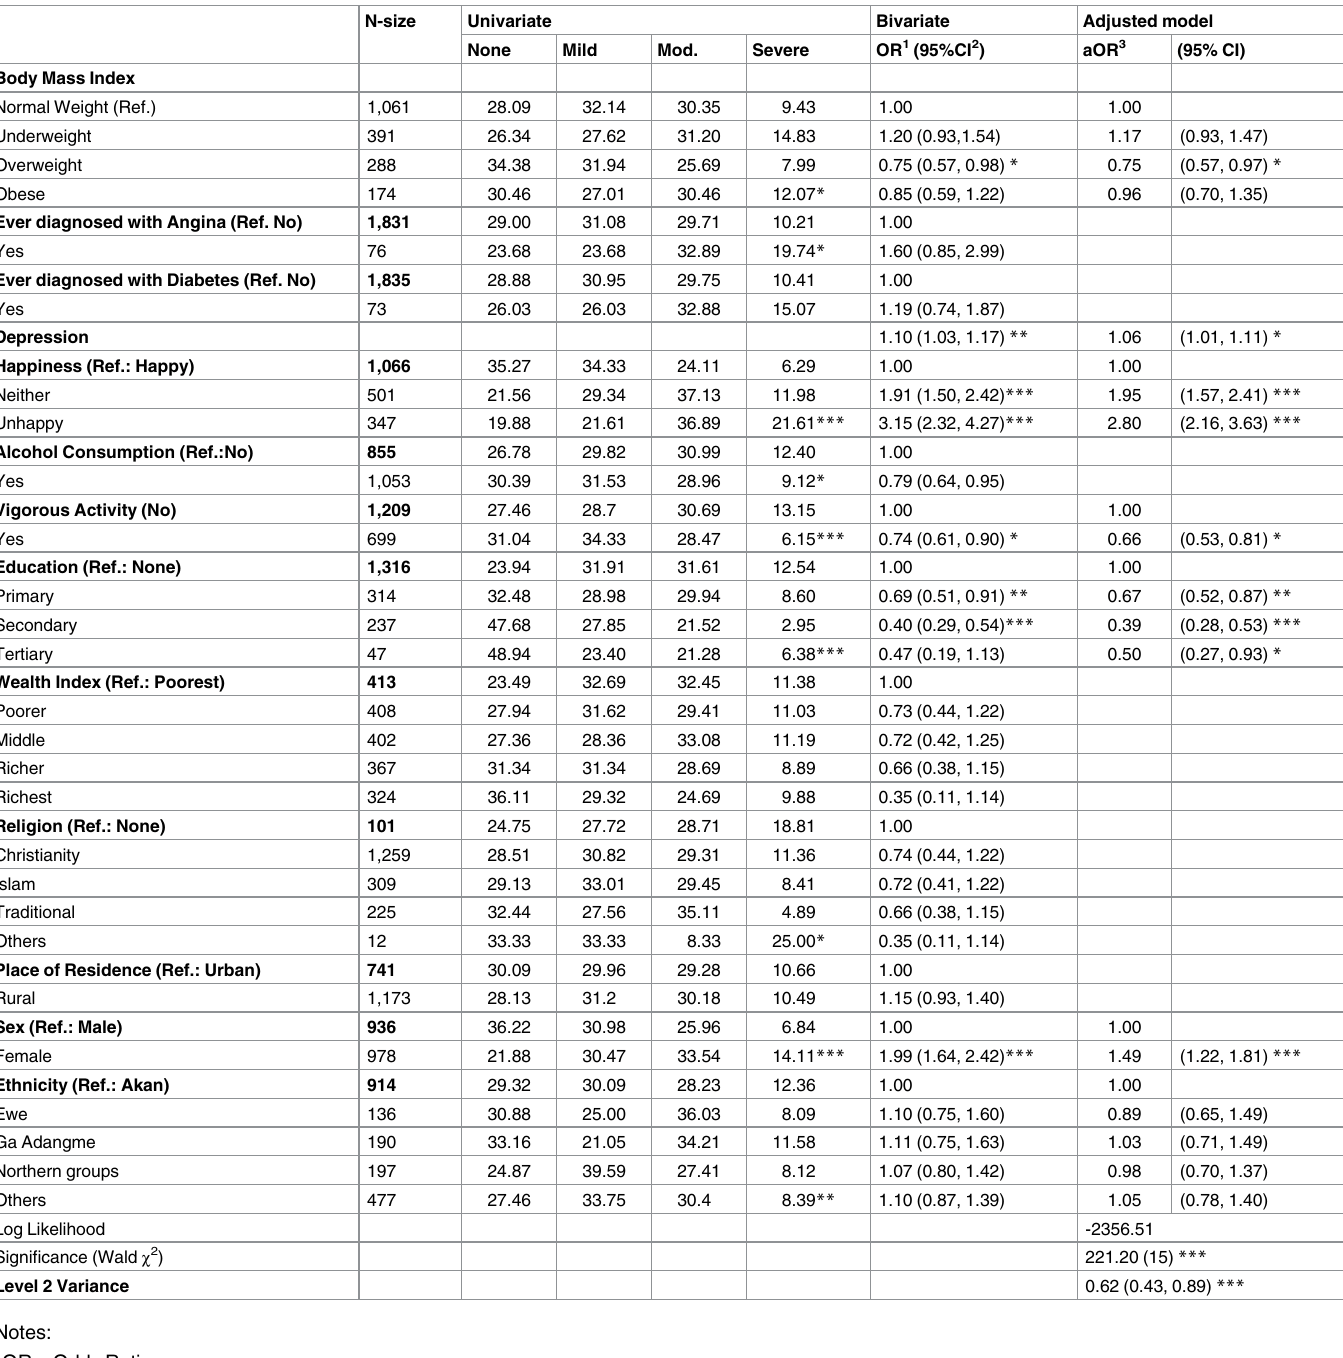
Table 5. Univariate, bivariate and adjusted results of generalized linear mixed effect ordinal logit models of difficulties with learning a new task on elderly obesity. N-size Univariate Bivariate Adjusted model None Mild Mod. Severe OR 1 (95%CI 2 ) aOR 3 (95% CI) Body Mass Index Normal Weight (Ref.)